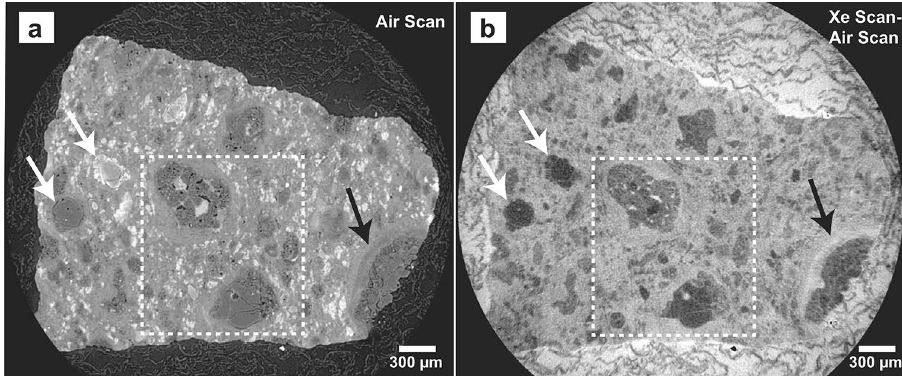
Figure 1. XCT Slice 420. ( a ) Air scan ( b ) Xe scan—Air scan (i.e., relative amount of infiltrated Xe). In ( b ) the darkest areas represent no Xe penetration, the lightest areas show where Xe has penetrated. The highest amount of Xe is present within the space surrounding the sample; the structure visible is that of the Kimwipe™ which surrounded the sample. The matrix shows a relatively higher proportion of Xe infiltration compared to the chondrules. White arrows mark two chondrules with significantly different X-ray attenuation (a) that both show relatively low Xe penetration (i.e., are non-porous) (b), confirming that the subtraction dataset in (b) shows only Xe infiltration (i.e., relative porosity) and not the X-ray attenuation of the materials. Black arrow highlights layering of relative xenon penetration within the rim of a chondrule. White dashed box shows location of Fig.